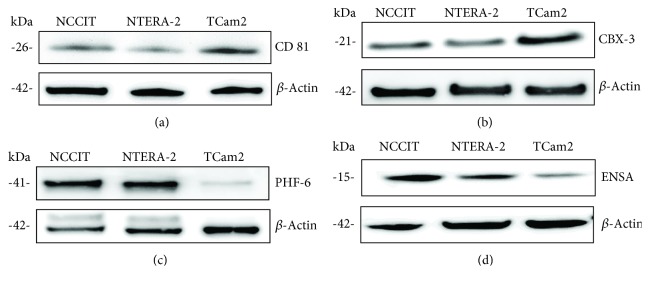
In vitro validation of differentially expressed proteins. In line with the results of the SILAC method and mass spectrometry, CD81 and CBX-3 show markedly higher expression in TCam-2 than in NTERA-2 (a, b). Conversely, PHF-6 and ENSA show markedly higher expression in NTERA-2 than in TCam-2 cells (c, d).